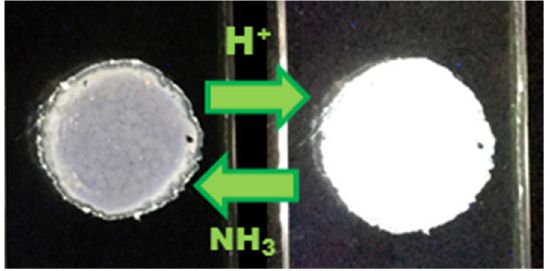
Figure 5. Filmed with 1,8-naphthalimide 4 glass exposed to HCl and NH 3 vapors.